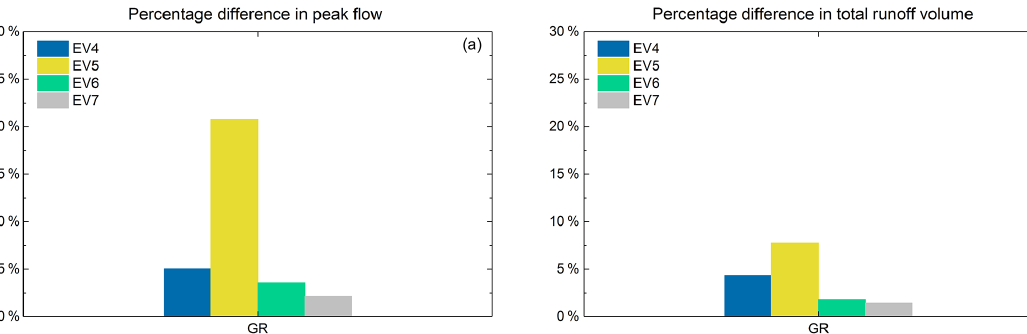
Figure 19. (a) Percentage difference in peak flow of GR scenarios under the four syntactic rainfall events. (b) Percentage difference in total runoff volume of GR scenarios under the four syntactic rainfall